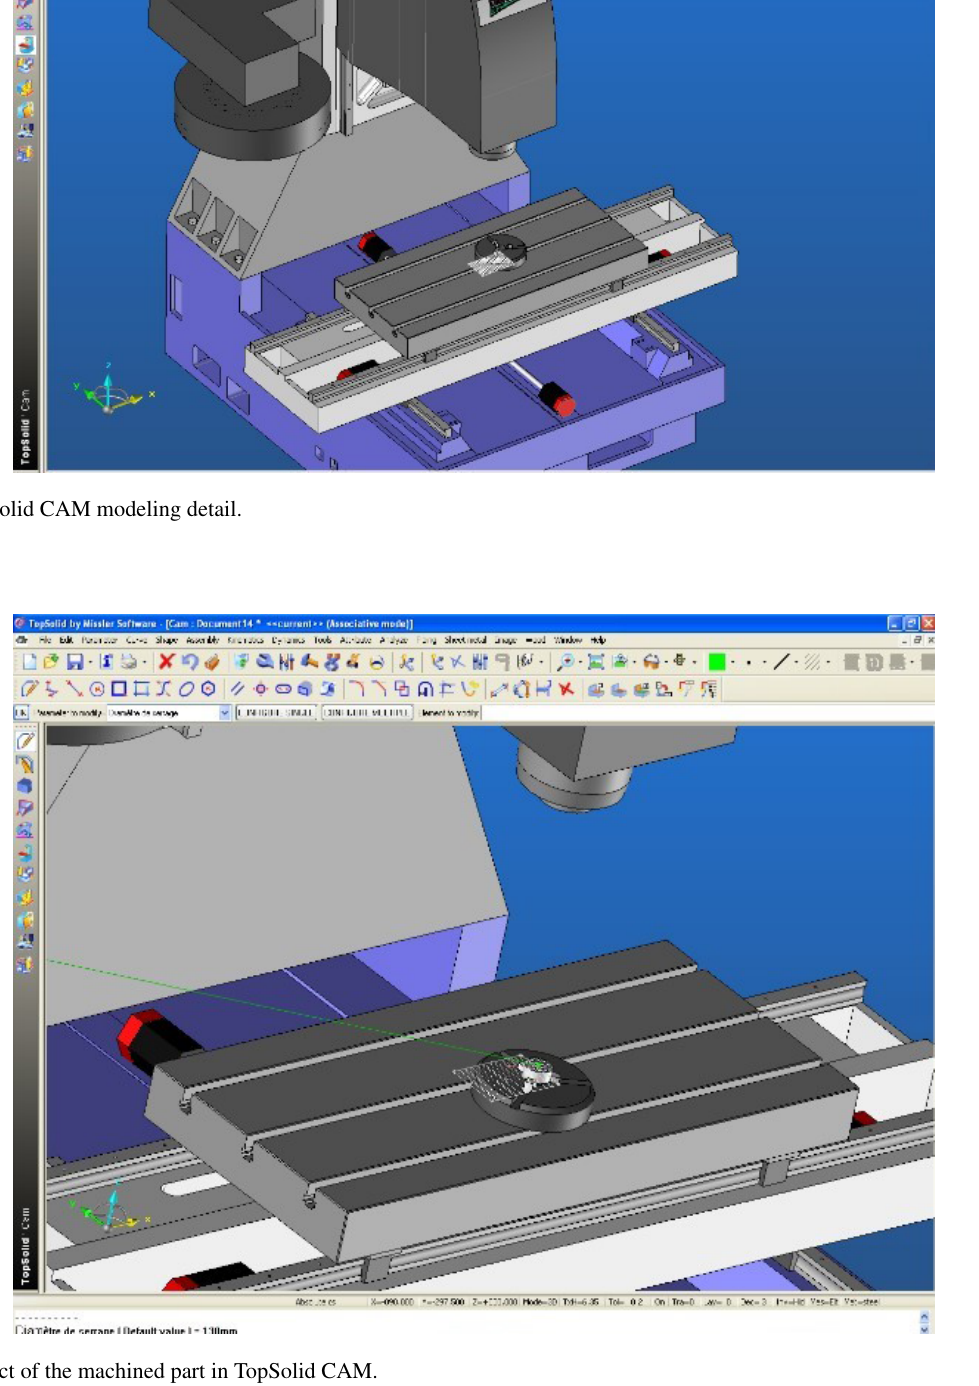
Figure 17. Aspect of the machined part in TopSolid